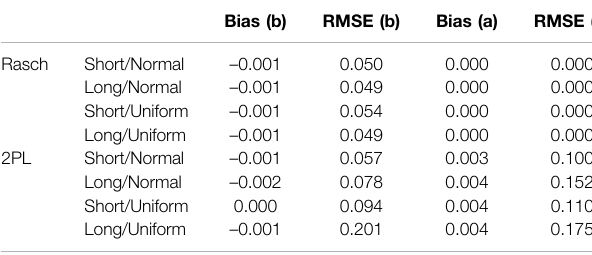
TABLE 2 | Non-optimal item allocation in second-stage